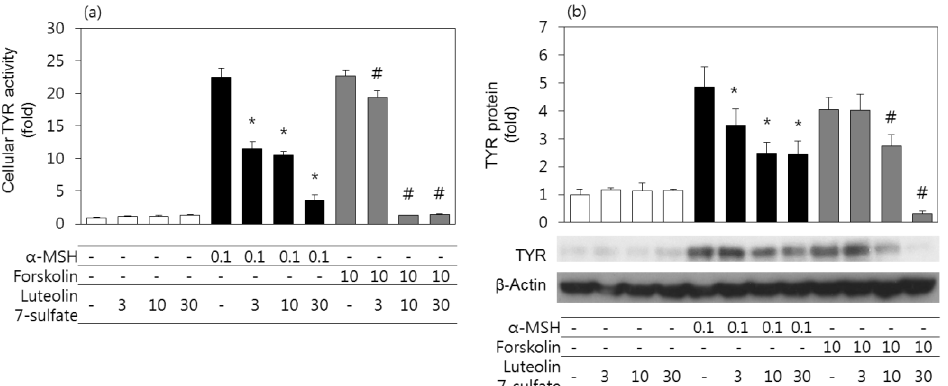
Figure 2. Effects of luteolin 7-sulfate on cellular tyrosinase (TYR) activities and TYR protein levels. B16-F10 cells were pretreated with luteolin 7-sulfate at varied concentrations and stimulated with 0.1 μM α-melanocyte-stimulating hormone (α-MSH) or 10 μM forskolin for 24 h. Cell lysates were used for the TYR activity assay ( a ), and western blotting of TYR protein comparing with β-actin ( b ). The means ± SEs of three independent experiments are presented. * p < 0.05 vs . α-MSH alone, # p < 0.05 vs . forskolin alone.